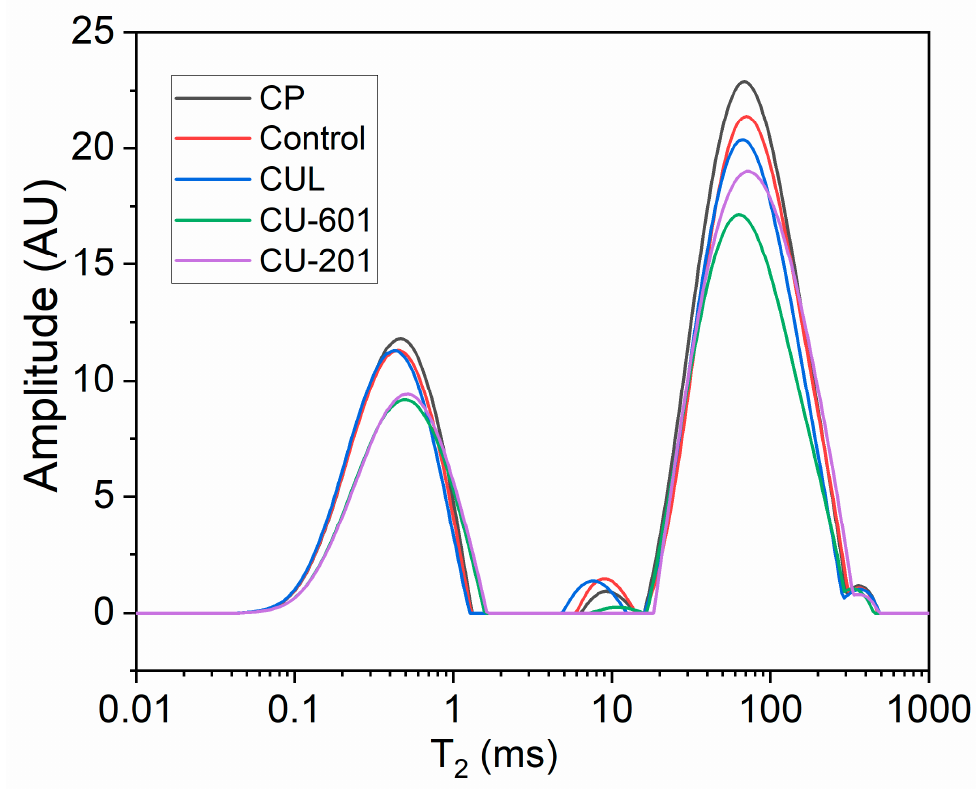
Figure 6. LF-NMR analysis of cookies prepared with partially added fish meat and various types of pectin. CUL, CP, CU-601, and CU-201 indicate the names of pectin which were added to the cookies.